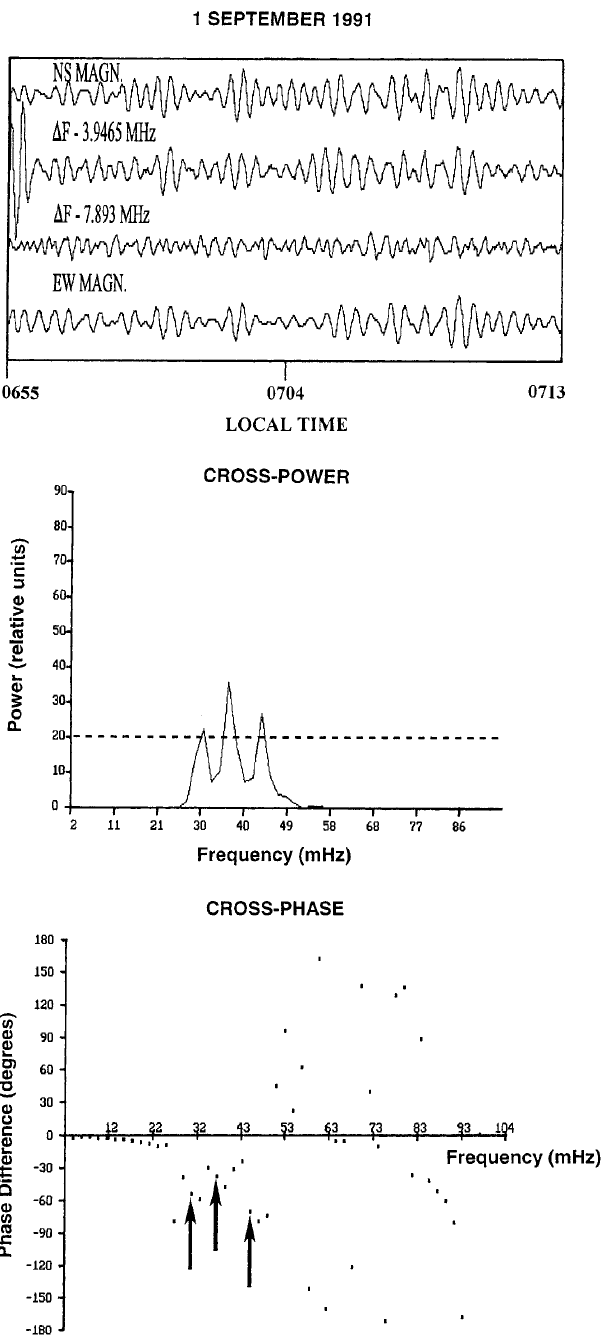
Fig. 8. Typical example of regular Pc 3 , 1 September 1991. Top panel shows Doppler and magnetometer time series, highpass filtered at 30 mHz, in the same format as for Fig. 2. Middle panel presents EW magnetometer/4 MHz Doppler cross-power spectrum for this event; bottom panel shows corresponding cross-phase spectrum. Values with acceptable cross-power are arrowed . Negative cross-phase denotes the ground pulsation lagging the ionospheric Doppler oscillation